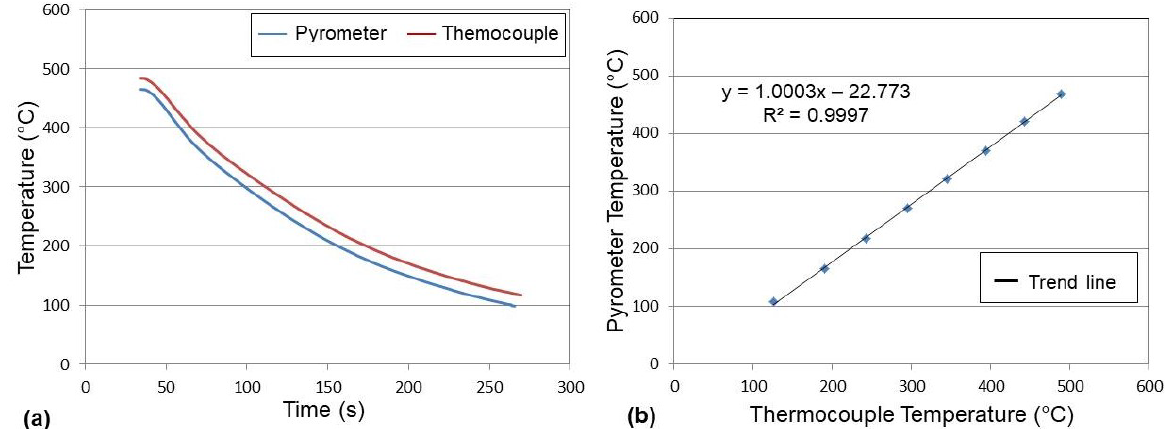
Figure 5. ( a ) Temperature profiles as a function of time, within a measurement range between 120 °C and 487 °C, with the emissivity coefficient set (ε set ) at 0.99 for the pyrometer; ( b ) corresponding fitting curve and calibration equation.